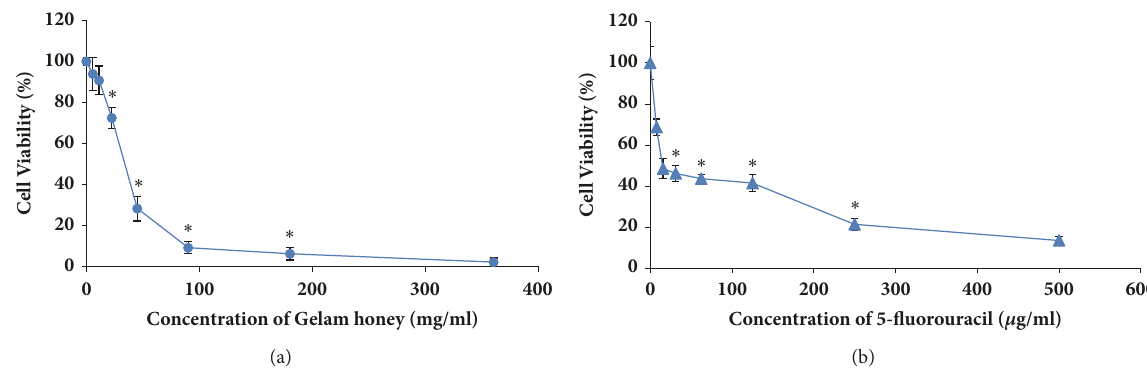
Figure 1: Cytotoxicity of GH and 5-FU against HT-29 cells after 72 h of treatment. The CD 50 of GH was 36.2 mg/ml (a) and the CD 50 of 5-FU was 15.5 𝜇 g/ml (b). Each point represents the mean of the results of three independent experiments. Error bars represent means ± S.E.M. of the three independent experiments. ∗ Statistical significance (P < 0.05) between control cells and treatment groups.